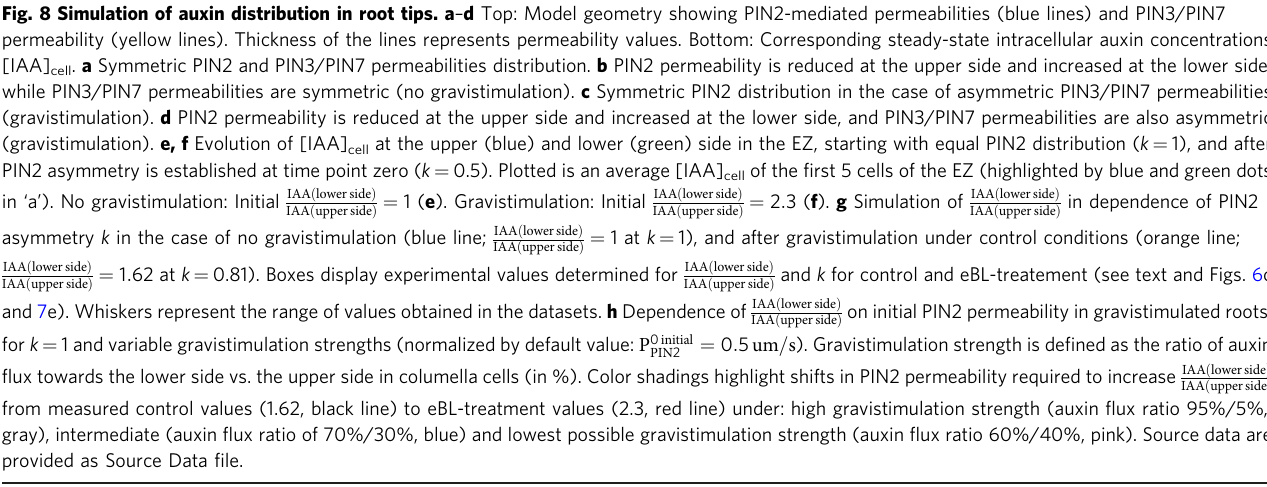
Fig. 8 Simulation of auxin distribution in root tips. a – d Top: Model geometry showing PIN2-mediated permeabilities (blue lines) and PIN3/PIN7 permeability (yellow lines). Thickness of the lines represents permeability values. Bottom: Corresponding steady-state intracellular auxin concentrations [IAA] cell . a Symmetric PIN2 and PIN3/PIN7 permeabilities distribution. b PIN2 permeability is reduced at the upper side and increased at the lower side, while PIN3/PIN7 permeabilities are symmetric (no gravistimulation). c Symmetric PIN2 distribution in the case of asymmetric PIN3/PIN7 permeabilities (gravistimulation). d PIN2 permeability is reduced at the upper side and increased at the lower side, and PIN3/PIN7 permeabilities are also asymmetric (gravistimulation). e, f Evolution of [IAA] cell at the upper (blue) and lower (green) side in the EZ, starting with equal PIN2 distribution ( k = 1), and